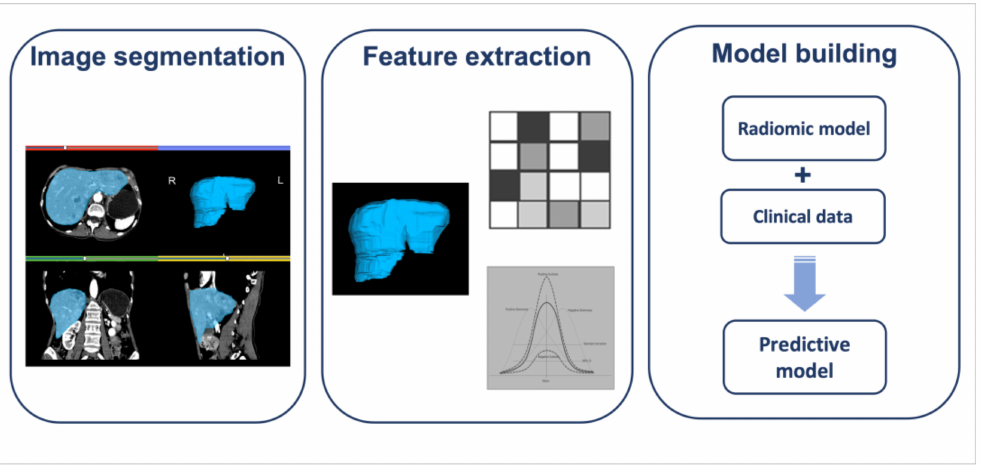
Figure 5. Graphical representation of radiomic workflow from liver segmentation, in panNEN with liver metastases, to build a predictive